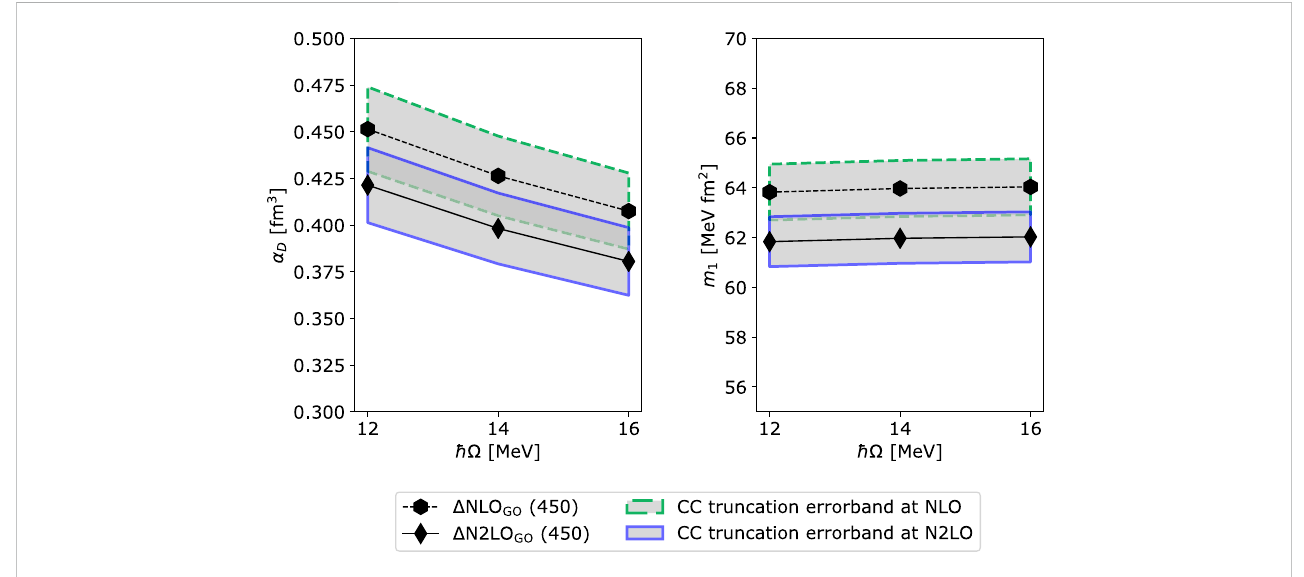
FIGURE 5 The Z Ω -convergence pattern of α D and m 1 for 8 He calculated with Δ NLO GO (450) and Δ N2LO GO (450) at fi xed N max =14. The green and blue bands indicate the CC truncation uncertainty. The black points are the results obtained including 3 p -3 h excitations in both the ground- and excited-state